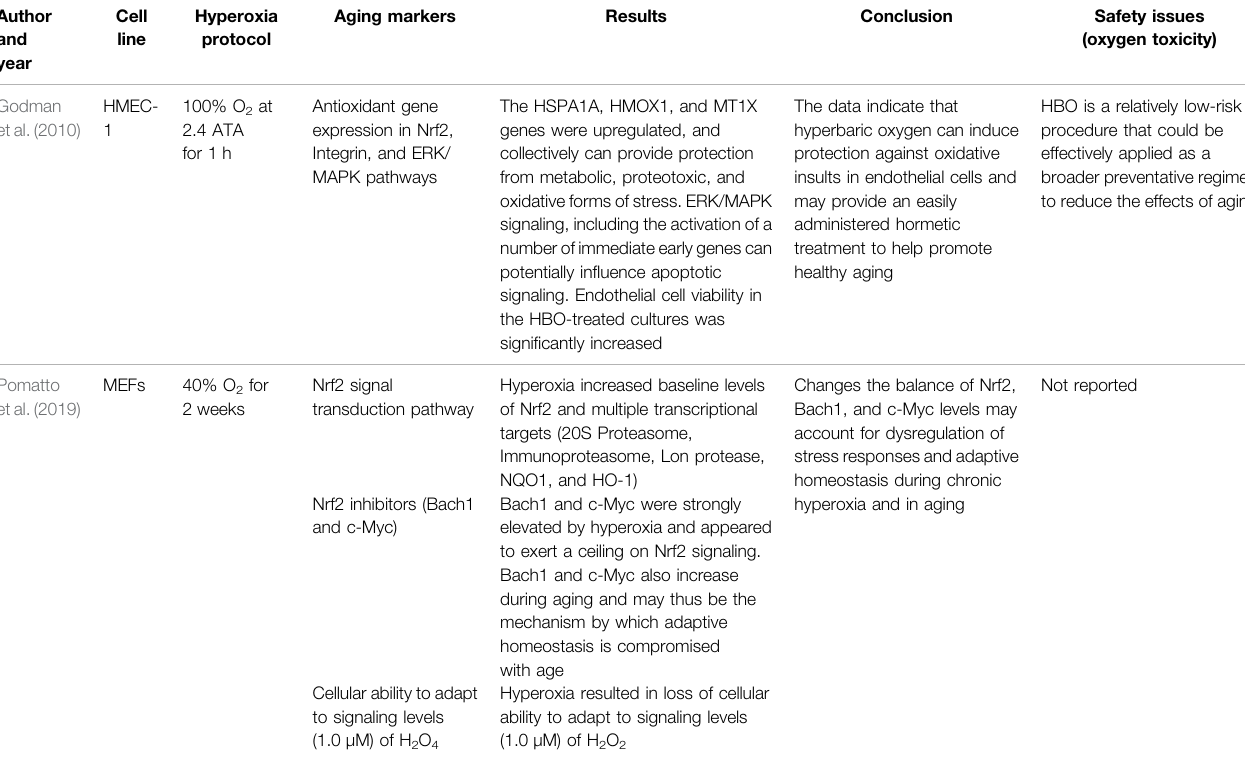
TABLE 2 | The effect of hyperoxia on aging markers in cell